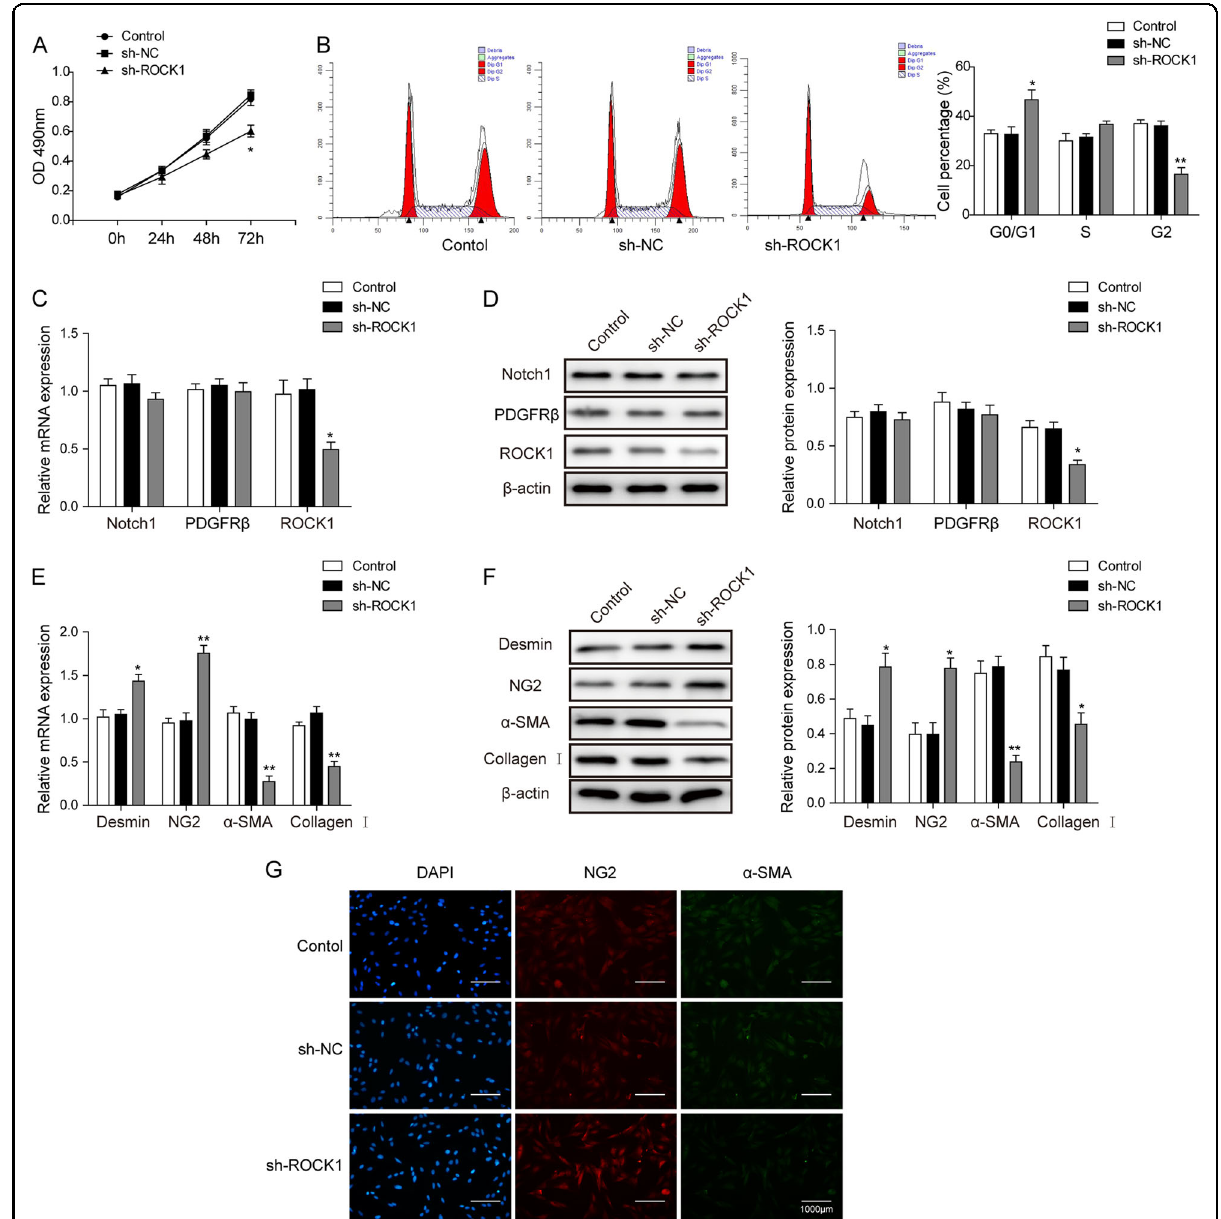
Fig. 4 ROCK1 is downstream of Notch1/PDGFR to mediate pericyte proliferation. a The MTT assay for cell viability after ROCK1 knockdown. b Flow cytometry for cell cycle analysis of pericytes from the control, sh-NC, and sh-ROCK1 pericyte cells. c Relative mRNA expression of Notch1, PDGFR β , and ROCK1. d Western blot for Notch1, PDGFR β , and ROCK1 protein expression. e Relative mRNA expression for cell marker genes. f Western blot for quanti fi cation of cell markers. g Immuno fl uorescent staining for cell surface markers indicating pericyte differentiation. The means ± SD in the graph present the relative levels from three replicates. * p <